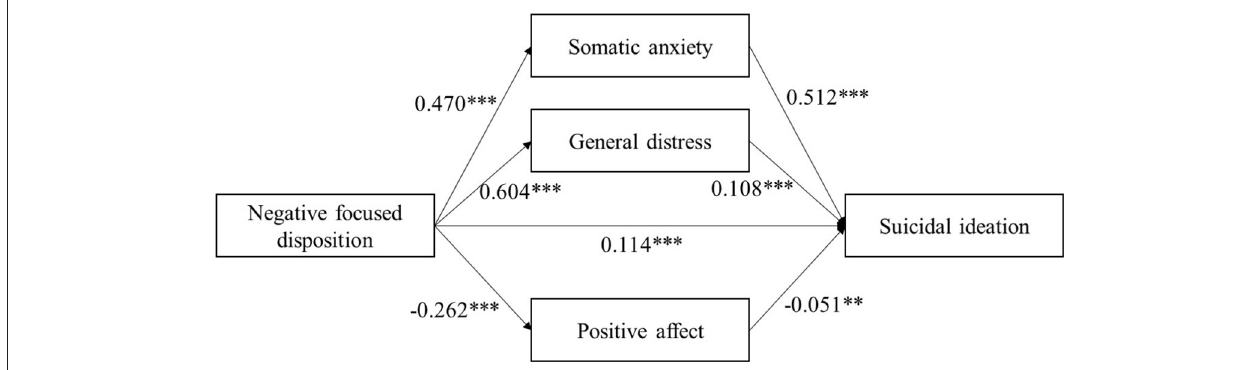
FIGURE 1 | Mediation of somatic anxiety, general distress, positive affect and between negative focused disposition and suicidal ideation. ** p < 0.01; *** p <